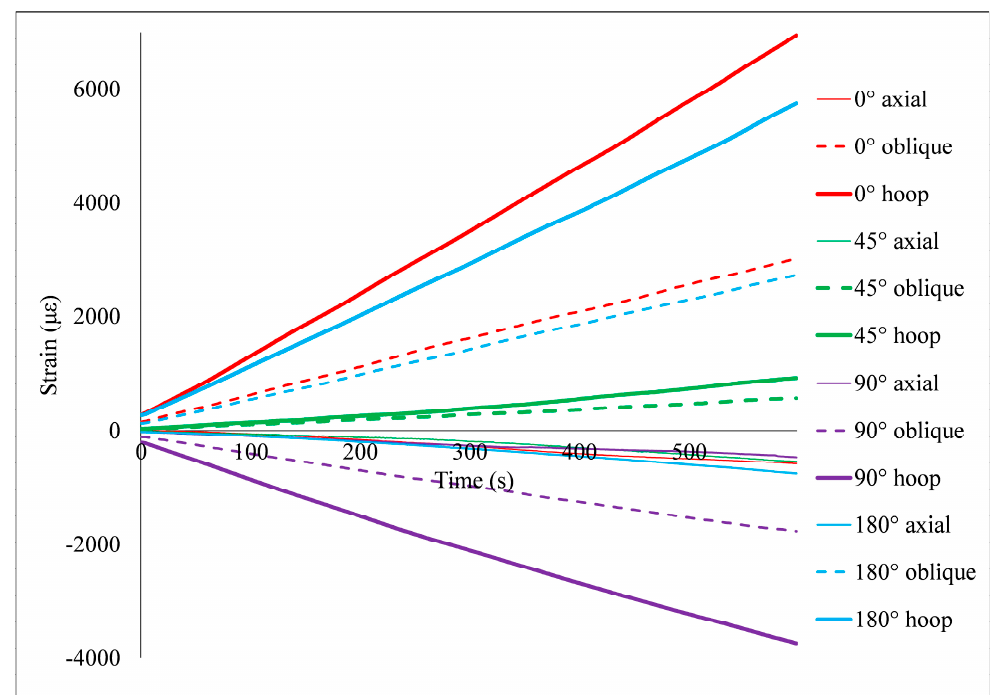
Figure 12. A typical strain-time curve for the inner stiffened type of DN500.